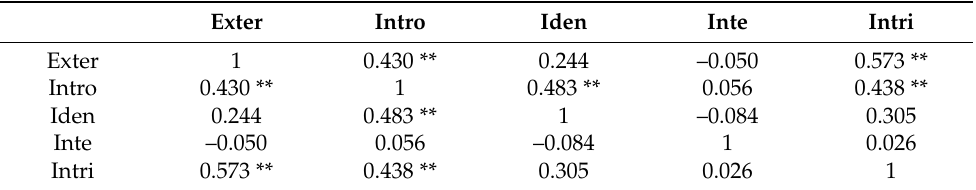
Table A3. Correlations among the five motivational subscales for the group with >10 years of experience.